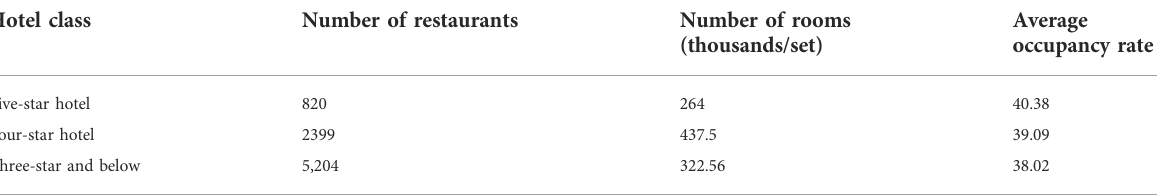
TABLE 1 Basic information on star-rated hotels in China.